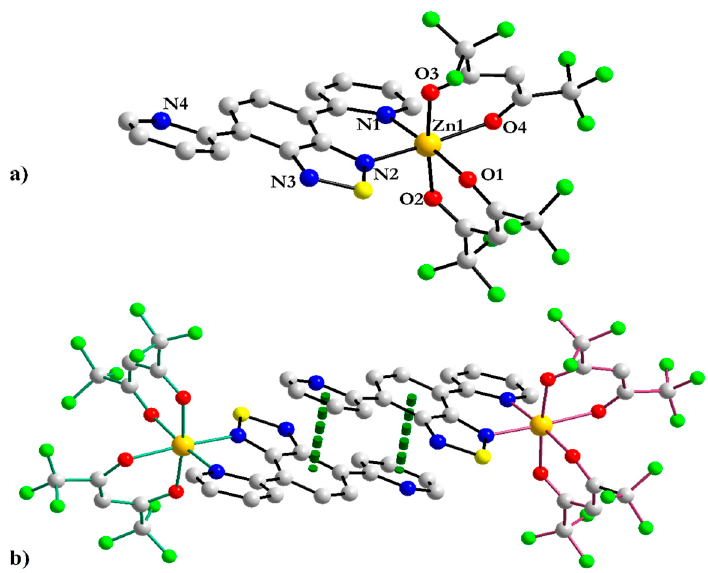
Table 1. Selected bond lengths (Å) for compounds 1 and 2 .